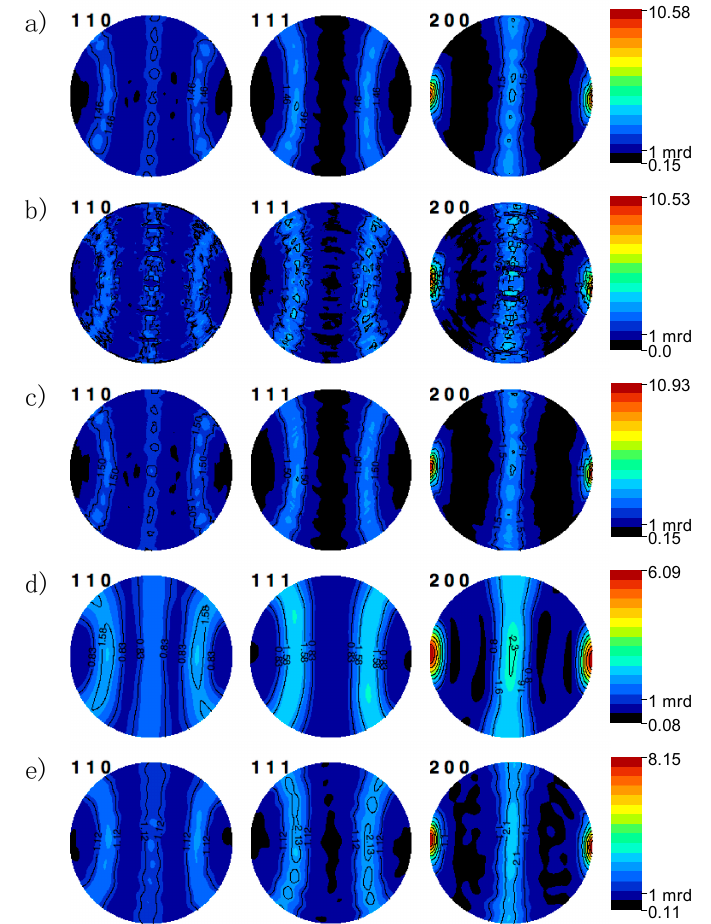
Figure 4. Comparison of the reconstructed pole figure refined using from neutron diffraction pole figure collected on a 5° spacing with ( a ) experimental reconstruction, ( b ) WIMV, ( c ) E-WIMV, ( d ) Spherical Harmonic n = 10, and ( e ) spherical harmonic n = 20. Note that the pole figures are rotated such that the left and right represent the sample normal direction.